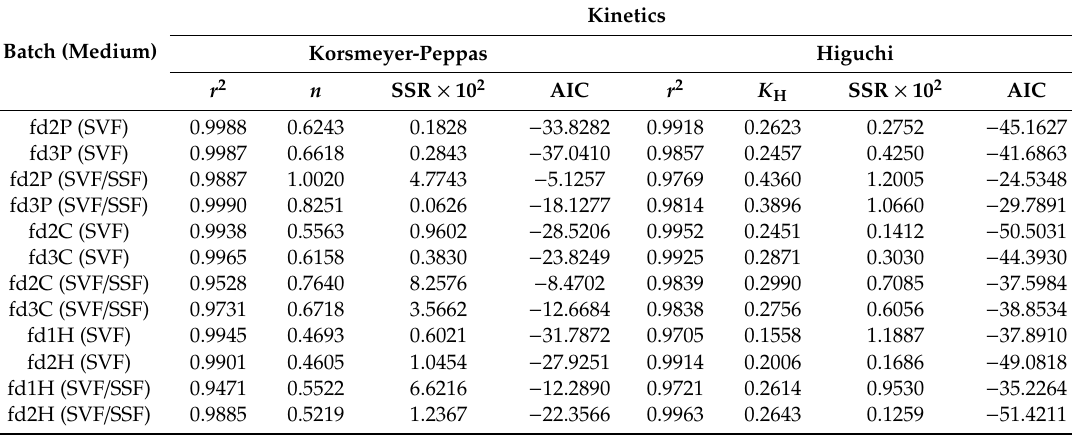
Table 2. Main parameters resulting from fitting the TFV release profiles to Korsmeyer-Peppas and Higuchi kinetics and their corresponding SSR and AIC